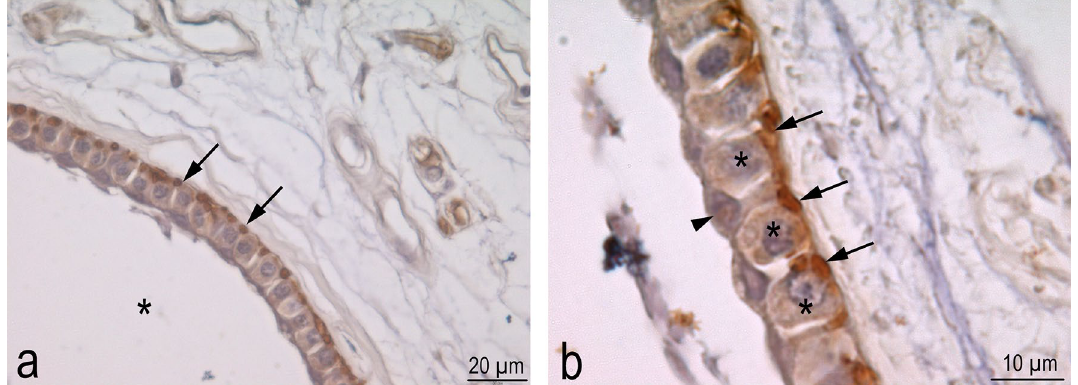
Figure 8. Histological sections of ampullary electroreceptors of C. monstrosa . Na + /K + -ATPase immunohistochemisty (brown) and Hematoxylin. a) The sensory epithelium lining the chambers (asterisk) presents basally Na/K-ATPase-like immunoreactivity (arrows). b) The epithelium is made up by at least two types of cells, the supporting cells (arrowhead) and the sensory cells. The Na/K-ATPase-like immunoreactivity in the basal part of sensory cells could highlight the nerve